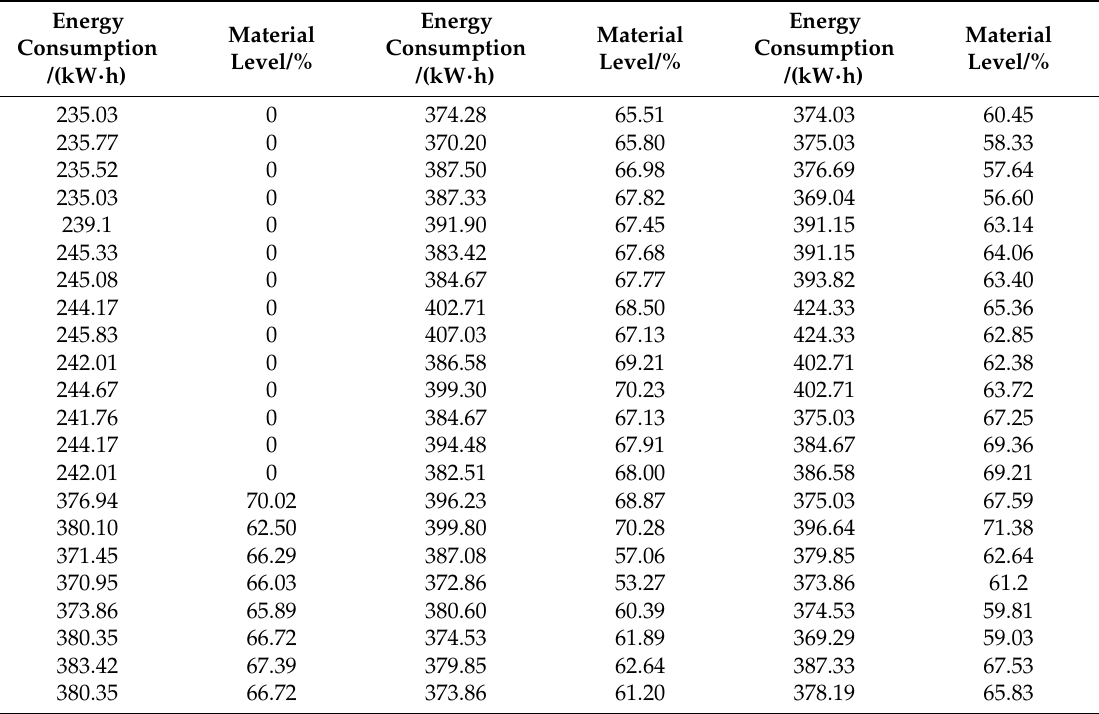
Table 1. Energy consumption and material